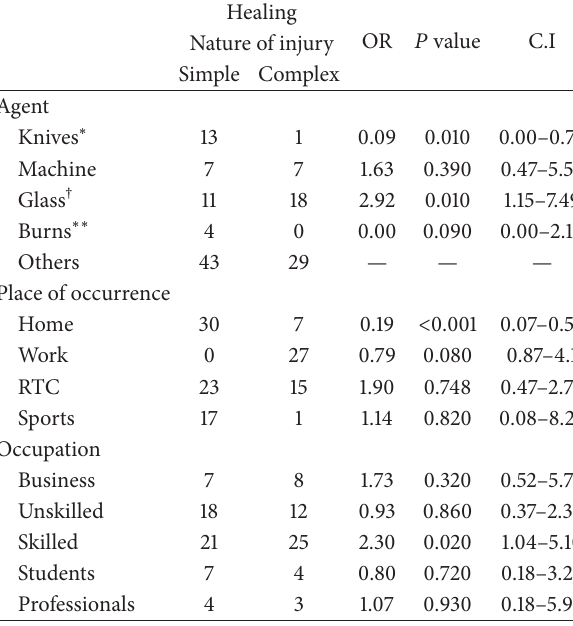
Table 3: The table shows time of surgery healing and type of